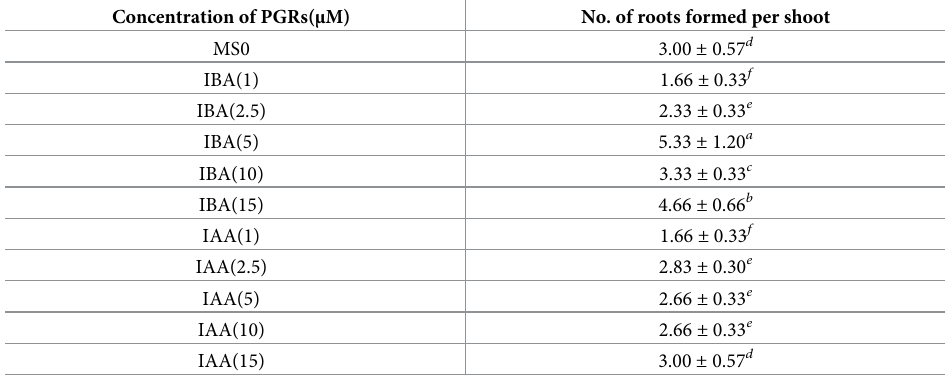
Table 5. Rooting of microshoots in liquid MS medium supplemented with different auxins.